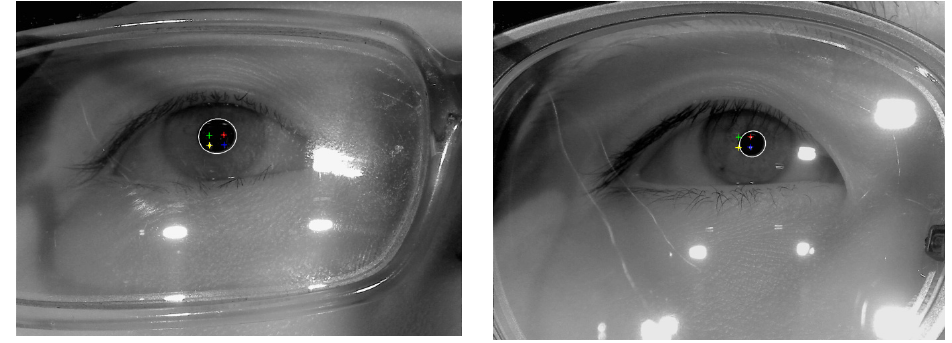
Figure 10. Examples of the results from the pupil detection and SR detection